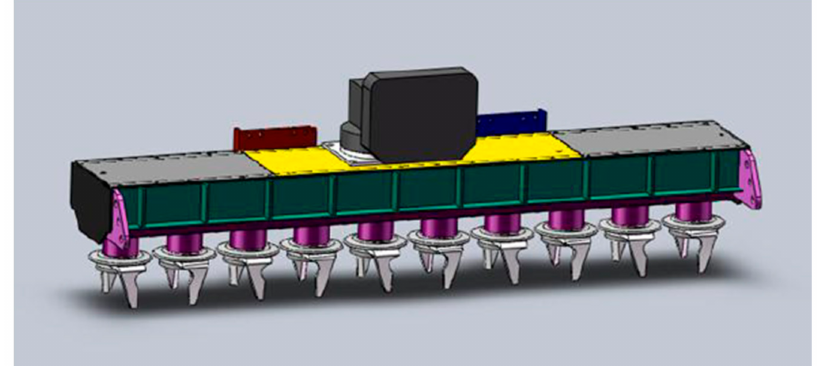
Figure 4. Vertical drive-type surface tillage machine.